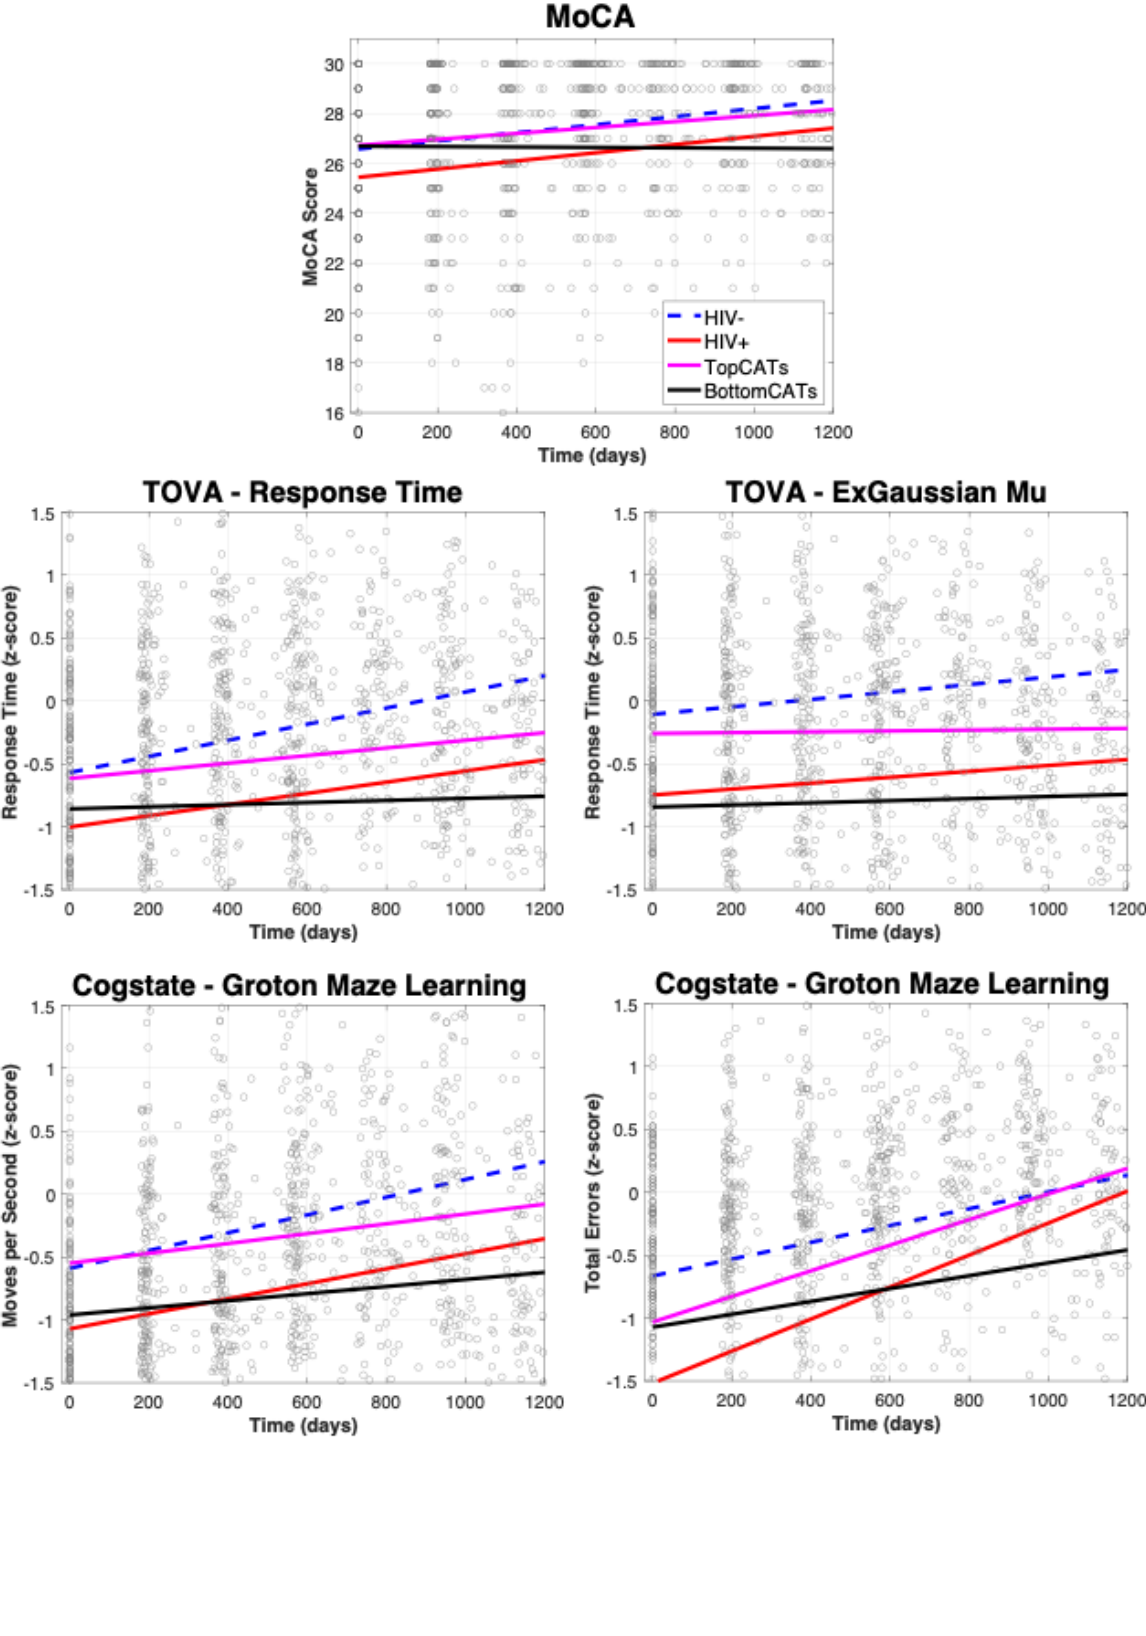
Figure 2. Trajectory of MoCA, TOVA, and Cogstate measures over time. The color scheme of lines for each group is the same as that in Figure 1. Cognitive measures of the TOVA and Cogstate were all transformed to z-scores using the HIV-negative group as normative values (the MoCA was not transformed). MoCA: Montreal Cognitive Assessment; TOVA: Test of Variables of Attention.TopCATs: HIV-positive individuals in the top 20% of central auditory test scores; BottomCATs: HIV-positive individuals in the bottom 20% of central auditory test